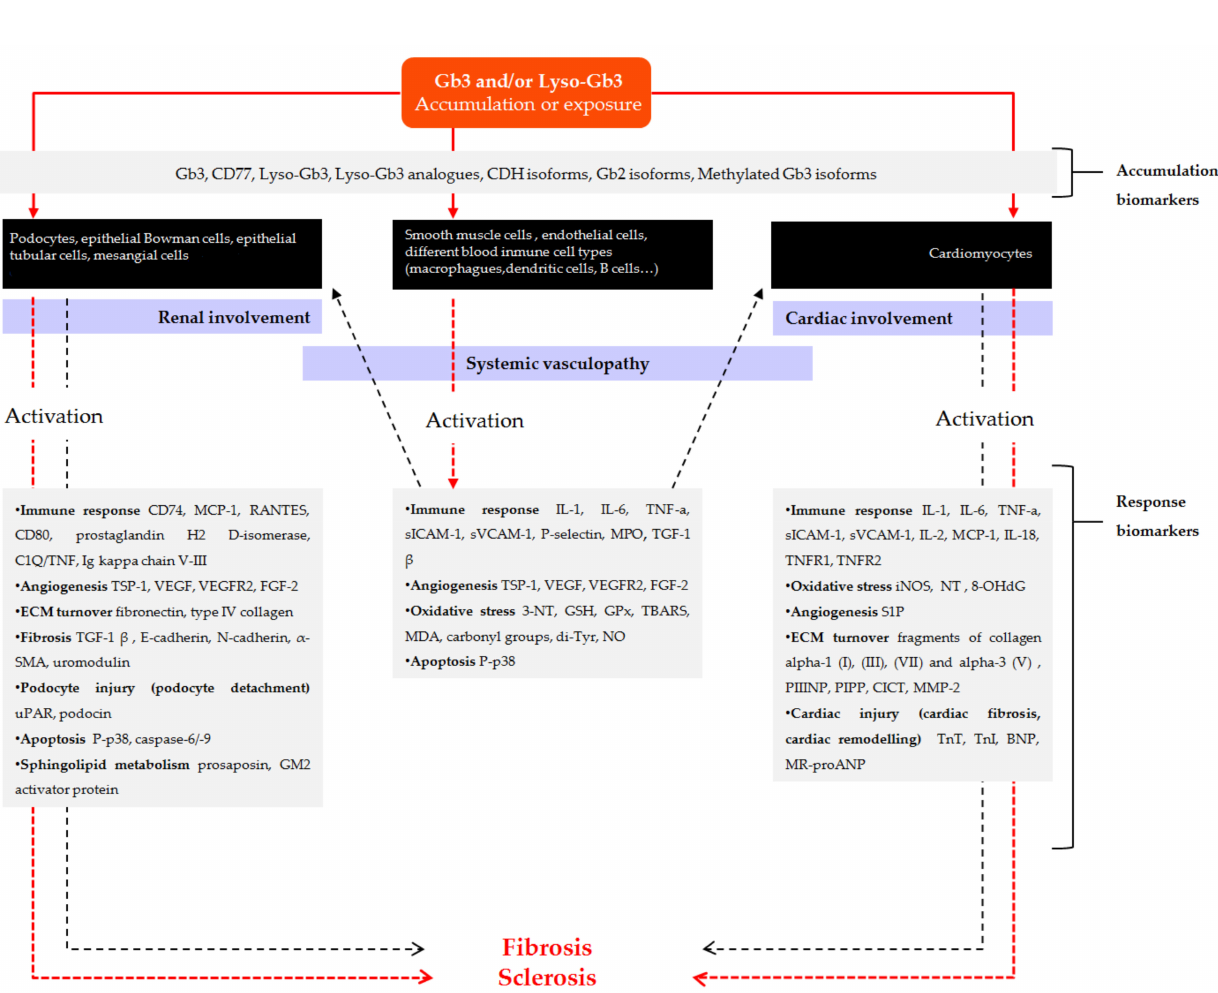
Figure 1. Scheme of the main pathogenic pathways with biomarkers involved in Fabry disease. Pathogenic mechanisms described in the development of vascular involvement are initiated from Globotriaosylceramide (Gb3) and/or Globotriao- sylsphingosine (lyso-Gb3) accumulation and/or chronic exposure to smooth muscle cells, endothelial cells or different blood immune cell types (solid red arrow), which in turn initiates different pathogenic cascades that contribute to the progression of vasculopathy (dashed red arrow). Inflammation derived from systemic vasculopathy may also be involved in the progression of disease related to cardiomyopathy and nephropathy (dashed black arrows). In addition, substrate can also accumulate or deposit on other cell types such us podocytes, other renal cells, or cardiomyocytes (solid red arrows), inducing different pathogenic mechanisms that may contribute to the development of renal and cardiac fibrosis. Gray boxes include different substrates related to the accumulation or exposure, as well as mediators involved in different pathways of response to the initial injury and progression towards fibrosis, which have been identified in clinical and experimental studies and that can be useful as diagnostic or follow-up biomarkers. α -SMA: α -smooth muscle actin; BNP: brain natriuretic peptide; C1Q/TNF: complement-c1q tumor necrosis factor-related protein; CICT: collagen type I carboxy-terminal telopeptide; CDH: ceramide dihexoside; FGF-2: fibroblast growth factor-2; Gb2: Galabiosylceramide; Gb3: Globotriaosylceramide; GSH: glutathione; GPx: glutathione peroxidase; hsTn: high sensitive Troponin; IL: interleukin; iNOS: inducible nitric oxide synthase; lyso-Gb3: Globotriaosylsphingosine; MCP-1: monocyte chemo-attractant protein; MDA: malondialdehyde; MMP-2: matrix metalloproteinase-2; MPO: myeloperoxidase; MR-proANP: midregional pro-atrial natriuretic peptide; NO: nitric oxide; NT: nitrotyrosine; 8-OHdG: 8-hydroxydeoxyguanosine; PIPP: procollagen type I carboxy-terminal propeptide; PIIINP: procollagen type III amino-terminal propeptide; sICAM-1: soluble intercellular adhesion molecule 1; sVCAM-1: soluble vascular cell adhesion molecule 1; S1P: sphingosine-1- phosphate; TBARS: thiobarbituric acid reactive species; TGF β -1: transforming growth factor beta-1; Tn: troponin; TNF- α : tumor necrosis factor alpha; TNFR: tumor necrosis factor receptor; TSP-1: thrombospondin-1; Tyr: tyrosine; uPAR: urokinase-type plasminogen activator receptor; VEGF: vascular endothelial growth factor; VEGFR: vascular endothelial growth factor